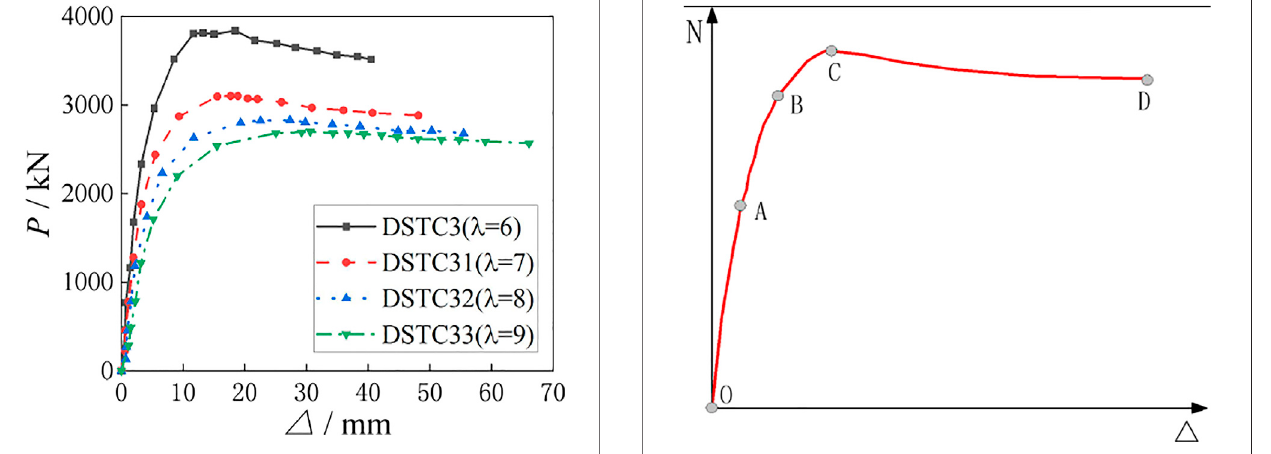
FIGURE 14 | Typical N- Δ